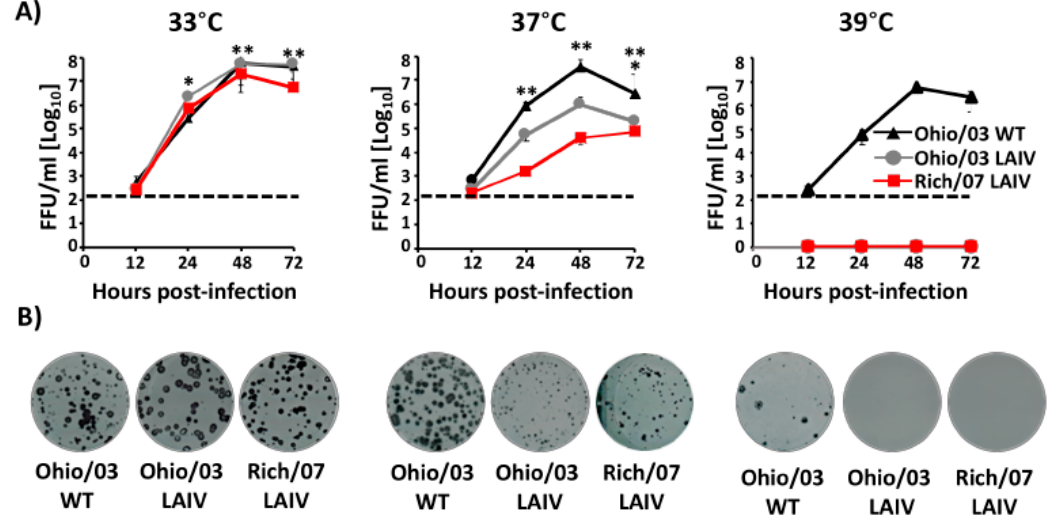
Figure 4. In vitro characterization of Ohio / 03 and Rich / 07 LAIVs: ( A ) Multicycle growth kinetics: MDCK cells (12-well plate format, 5 × 10 5 cells / well, triplicates) were infected (multiplicity of infection (MOI) 0.001) with Ohio / 03 WT, Ohio / 03 LAIV, or Rich / 07 LAIV and incubated at 33 ◦ C (left), 37 ◦ C (middle), and 39 ◦ C (right). Tissue culture supernatants from infected cells collected at 12, 24, 48, and 72 h p.i. were used to evaluate the presence of viruses by immunofocus assay (FFU / mL) using an anti-NP monoclonal antibody (HB-65). Data represent the means +/ - SDs of the results determined in triplicate wells. Dotted black lines indicate the limit of detection of the assay (200 FFU / mL). Lines below the limit of detection represent non-detected virus. p < 0.05: * Ohio / 03 WT vs. Ohio / 03 LAIV; ** Ohio / 03 WT vs. Rich / 07 LAIV. ( B ) Plaque assay: MDCK cells (6-well plate format, 1 × 10 6 cells / well) were infected with Ohio / 03 WT, Ohio / 03 LAIV, or Rich / 07 LAIV and incubated at 33 ◦ C (left), 37 ◦ C (middle), and 39 ◦ C (right). The plaque phenotype was analyzed at 72 h p.i. by immunostaining with the anti-NP monoclonal antibody